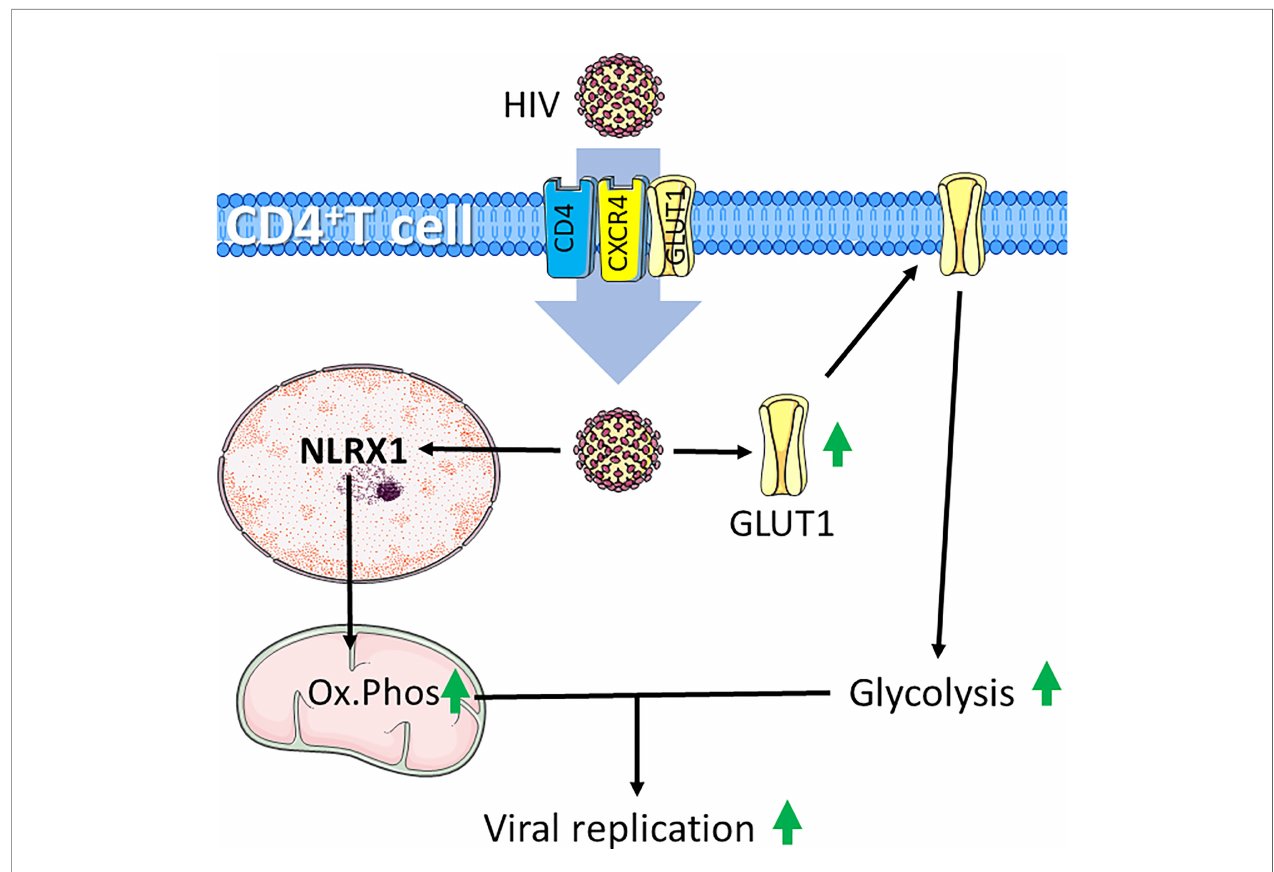
FIGURE 4 | HIV infection induces increased glycolysis and mitochondrial respiration in CD4+ T cells. HIV infects CD4+ T cells through interaction with CD4 and chemokine receptor CXCR4. HIV-infection supports glycolytic metabolism by increasing expression of the glucose transporter GLUT1, which can also be exploited to further infect CD4+ T cells. Additionally, HIV induces expression the of nucleotide-binding domain leucine-rich repeat-containing receptor X1 (NLRX1) to induce increased oxidative phosphorylation (Ox.Phos). The increased metabolic rate supports enhanced viral replication. Figure was created using assets from